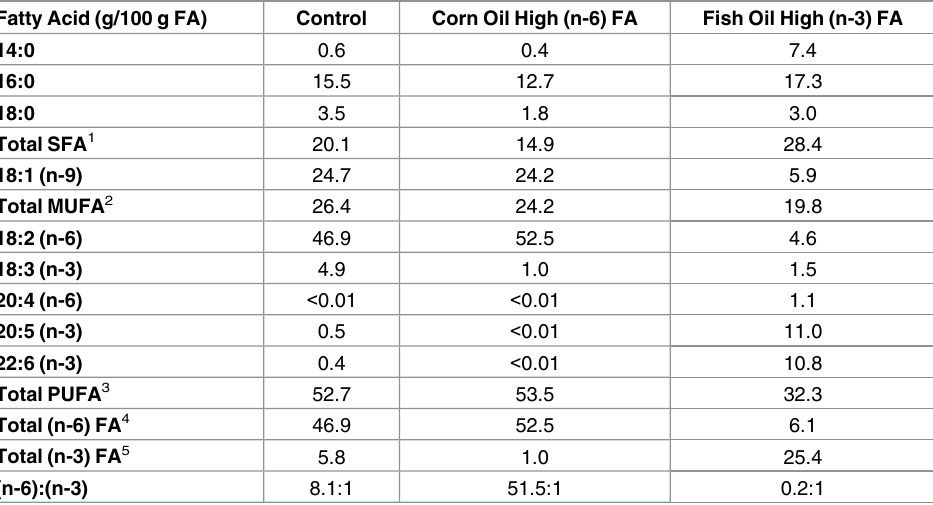
Table 2. Composition of selected FA in diets fed to mice for 12 weeks. Fatty Acid (g/100 g